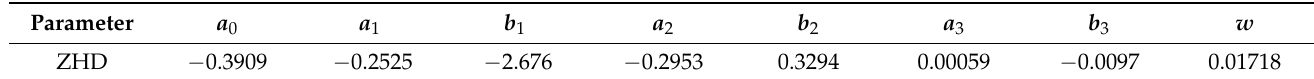
Table 1. The Fourier coefficients of the GPT3-ZHD bias in the Yangtze River Delta region during 2016–2018.